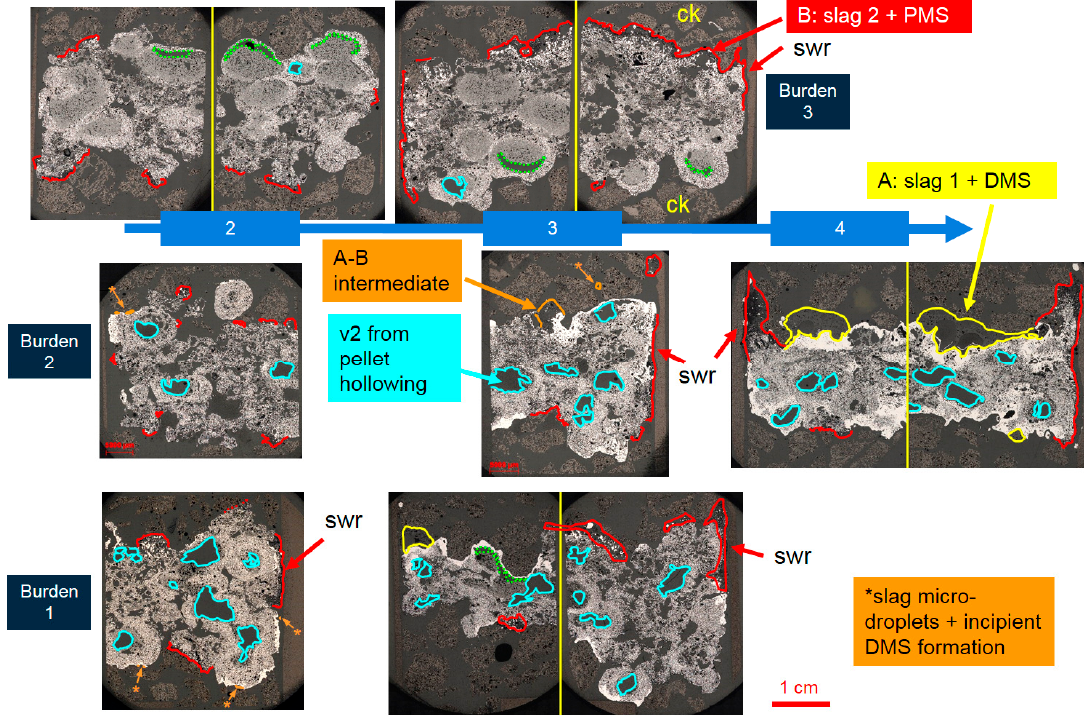
Figure 4. Light optical microscopy (LOM) imagery of vertical (longitudinal) sections from interrupted experiments for burdens 1–3 (M1-3). swr = sidewall reaction; v2 = secondary void. Dense metallic shell (DMS) appears white. Generally brighter areas are richer in metallic Fe, darker grey in wustite.